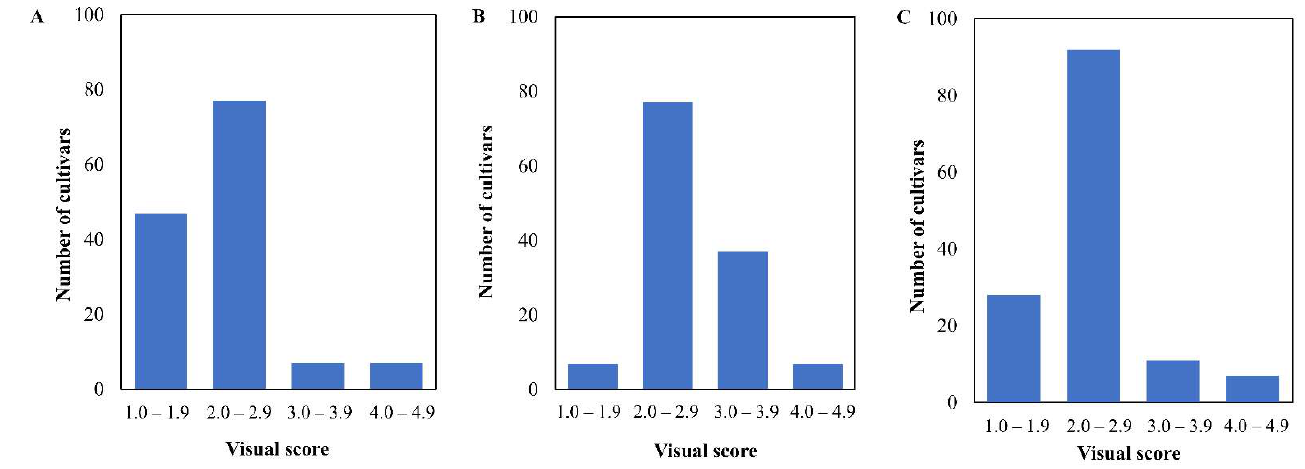
Figure 1. Frequency distribution of the response to herbicide bentazone with 138 Korean soybean cultivars. ( A ) Distribution of visual score in test 1. ( B ) Distribution of visual score in test 2. ( C ) Distribution of averaged visual score of the two tests. Visual score < 2.0, tolerance; 2.0–3.5, moderate tolerance; and >3.5, sensitive.